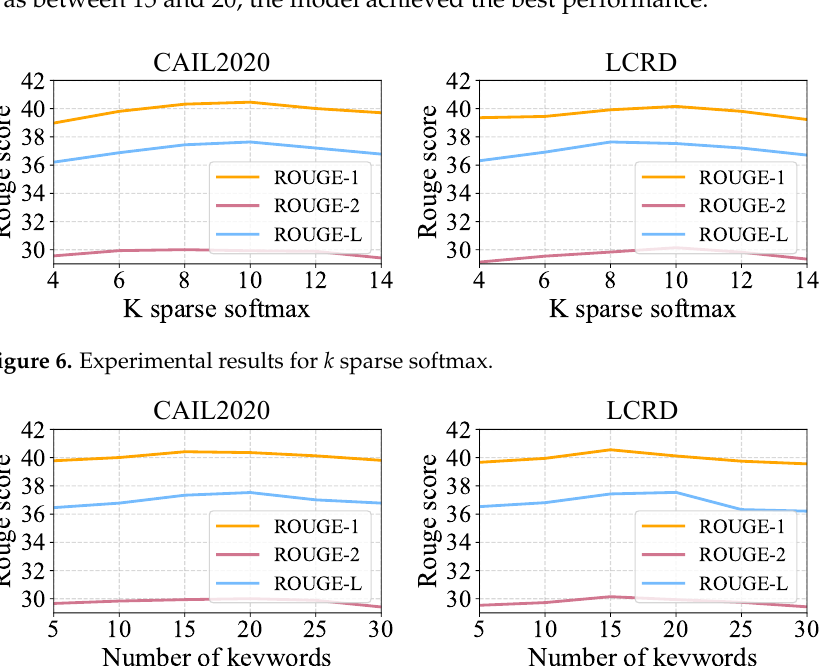
Figure 7. Experimental results for the number of